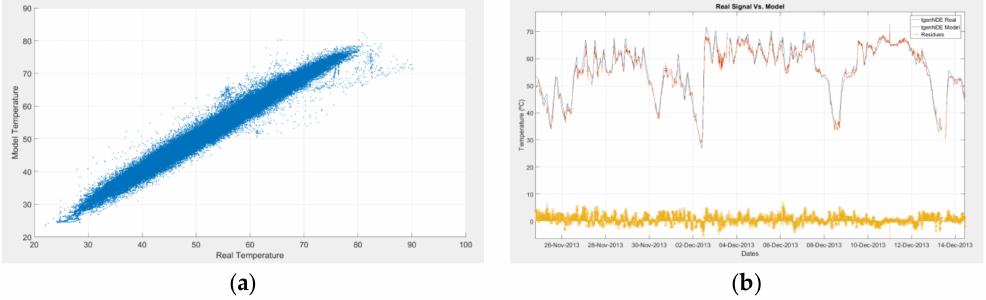
Figure 8. Generic Model: ( a ) Regression line; and ( b ) real temperature (in blue) and estimated temperature (in red) of the NDE bearing, and residues of the model (in yellow).